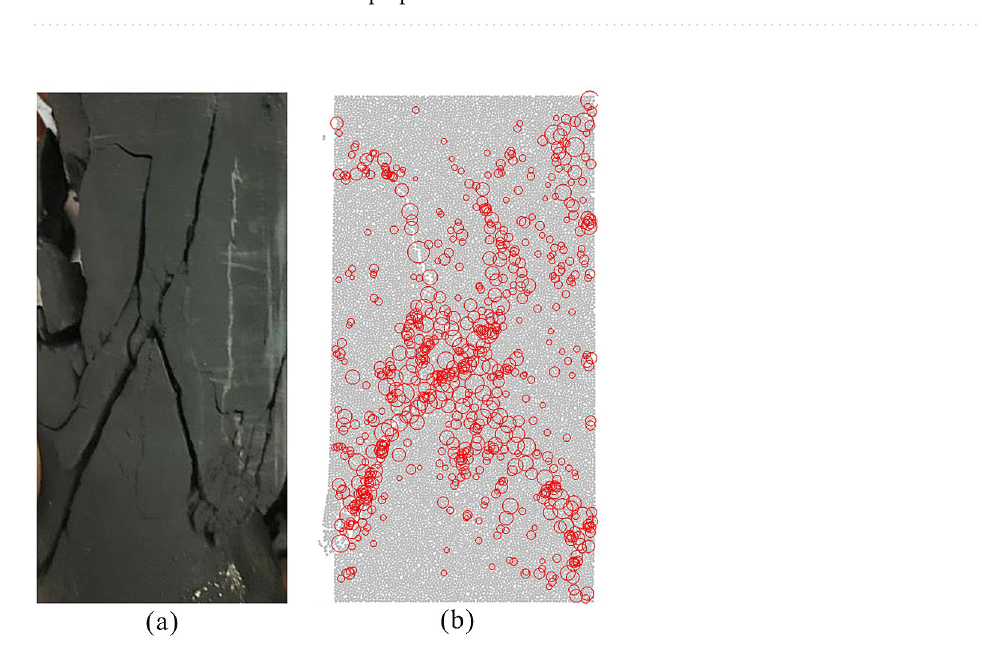
Figure 4. Calibration of the failure configuration between ( a ) experiment #2; and ( b ) simulation. The red circles correspond to simulated AE events, and the size of the circle represents the local